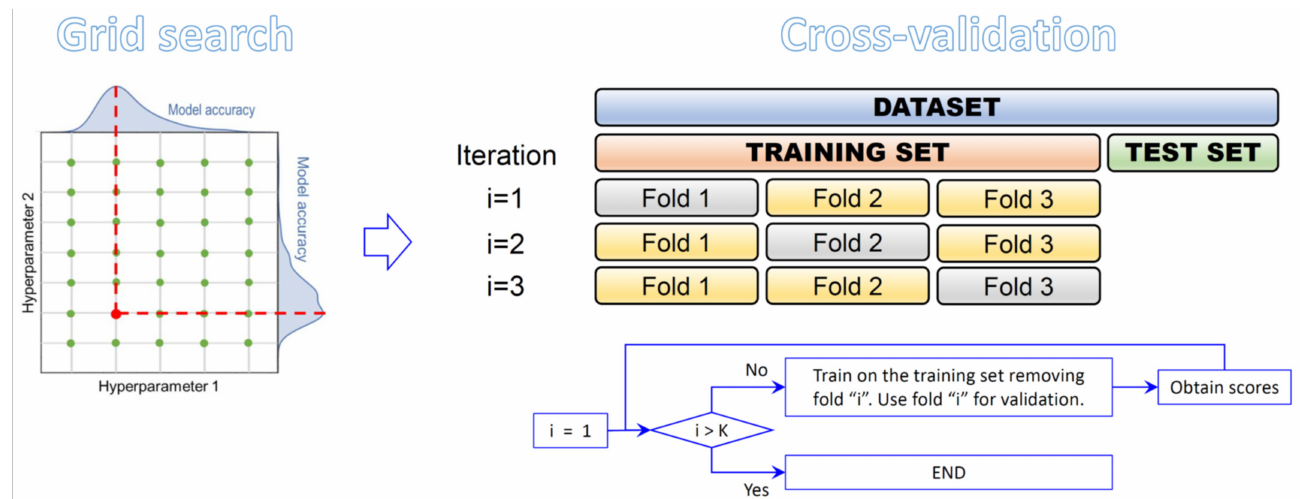
Figure 4. Schematic description of the procedure followed in this research for hyperparameter tuning. Grid search was used to obtain the combinations of the values of the hyperparameters. Then, a threefold cross validation method was implemented for hyperparameter